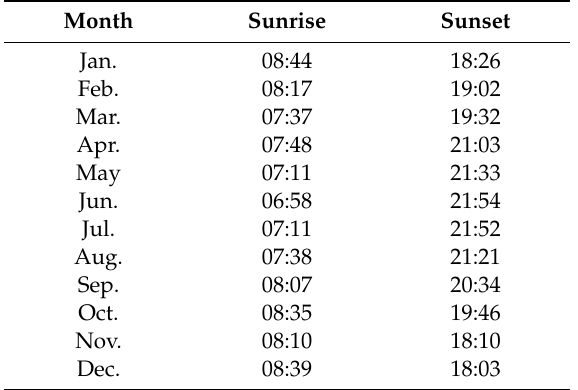
Table 2. Average values of sunrise and sunset used in the study. Month